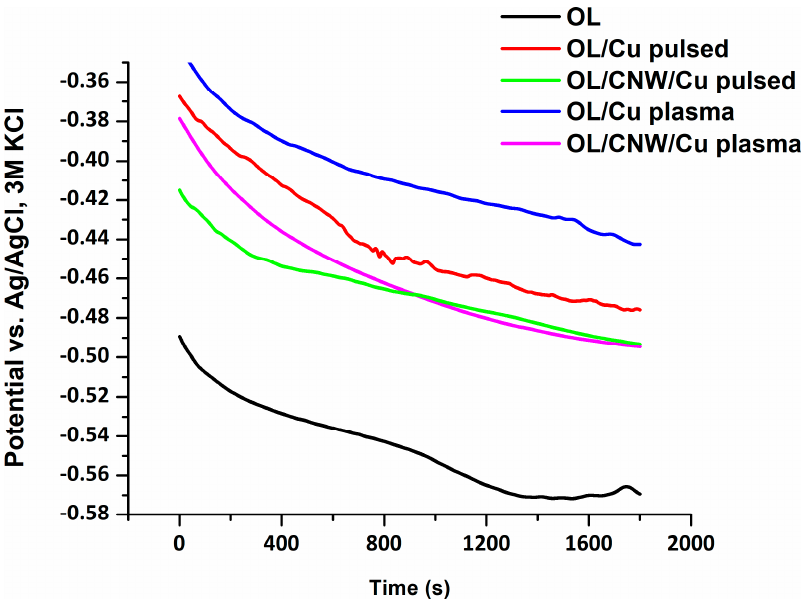
Figure 10. OCP determination in NaCl 0.9% vs. Ag/AgCl 3 M KCl for OL and all coated samples.